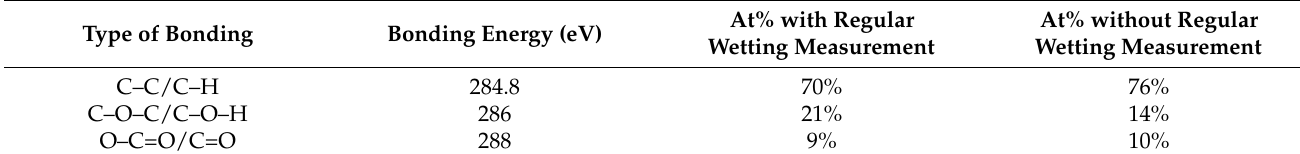
Table 4. Atomic percentages of the different carbon bonds calculated from the C1s spectra of the samples with no square pillars’ top irradiation textured under a CO 2 flow and for which wetting evolution measurements were and were not carried out.